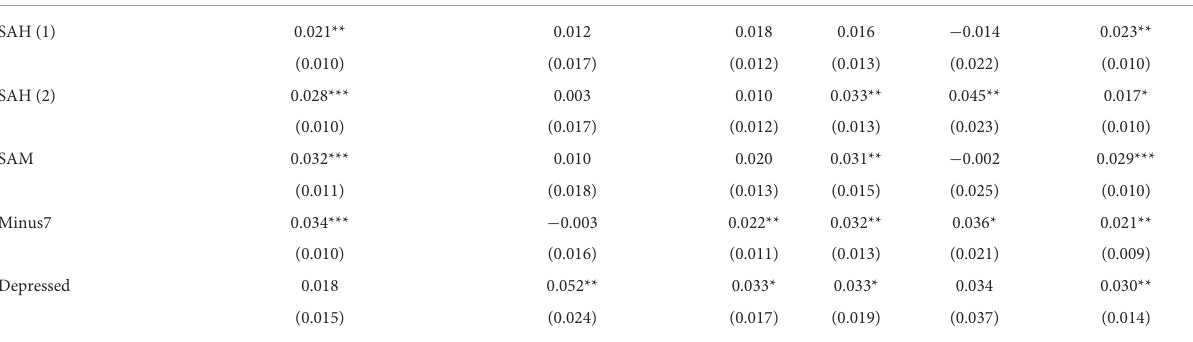
TABLE 7 Heterogeneity